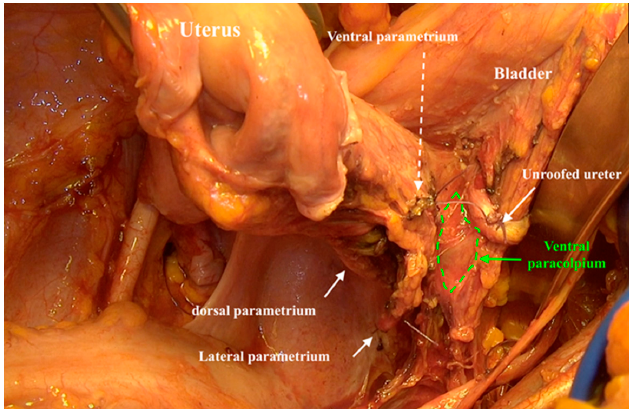
Figure 5. The cut-ends of ventral, lateral, and dorsal parametrium and illustrating the entire three-dimentional anatomy of paracolpium.